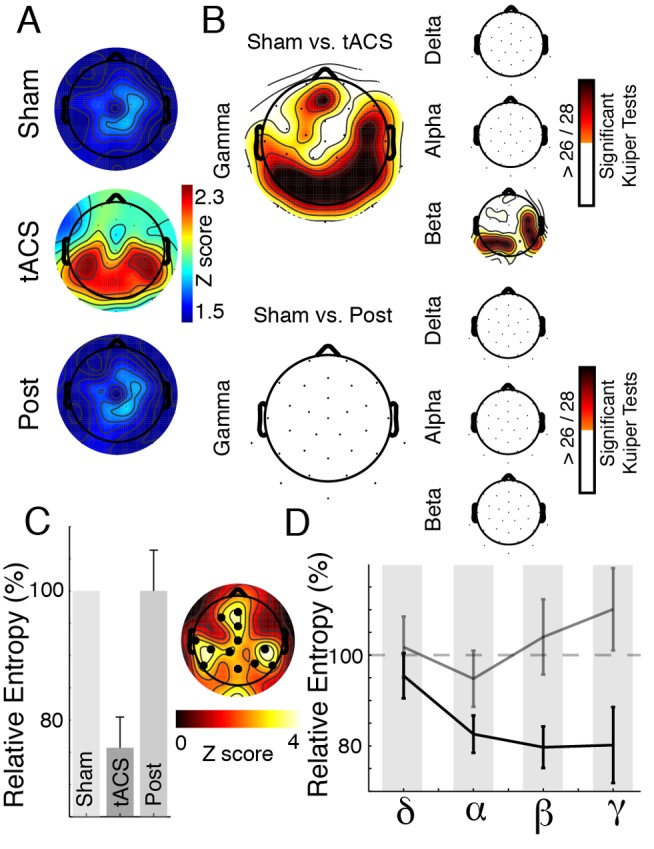
Signatures of gamma-band entrainment by tACS.(A) Results of Rao's spacing test, indicating an increase in non-uniform gamma phase distributions over parieto-occipital cortical areas during tACS. (B) Left: Results of Kuiper's test for unequal distribution of instantaneous phase angles in the gamma-band between sham/stimulation and sham/post, indicate a parieto-occipital maximum (statistical significance is assumed when >26 tests reach p<0.0016). Right: The same analysis applied to delta, alpha, and beta-bands. (C) Cluster analysis revealed a significant entropy decrease under parieto-occipital electrodes during stimulation as compared to sham (p = 0.004), but not when sham was compared to the post condition (p>0.05). A comparison of stimulation and post confirmed this difference (cluster test: p = 0.002). See also Data S1. (D) Relative entropy change at a posterior midline electrode during stimulation (dark grey line) and post (light grey line) indicated that the entropy decrease is not confined to the gamma-band (Data S1).